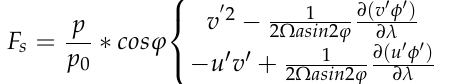
Figure 2. ( a ) The imposed sensible heating (unit: W/m 2 ) and ( b ) its regional mean heating vertical profile (unit: K/day) with the domain (24.5°N − 30.1° N, 95.6°E − 101.25° E). The purple line is the 2000 m elevation contour.